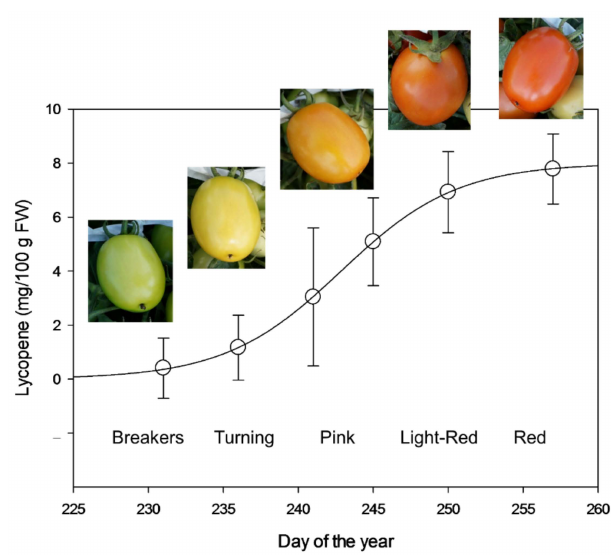
Figure 1. Lycopene evolution in processing tomatoes, cv. Calista, as measured during ripening in the